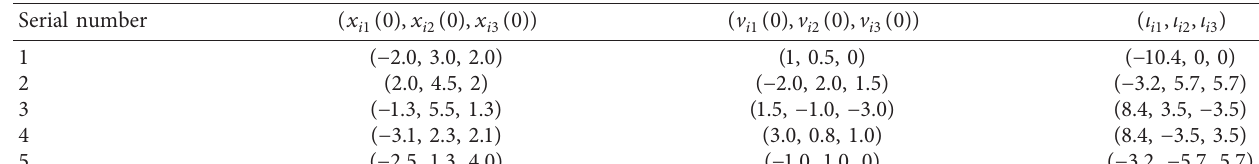
Figure 4: Communication network for dynamic whole motion. Table 2: Initial values and formation vectors for dynamic whole motion.